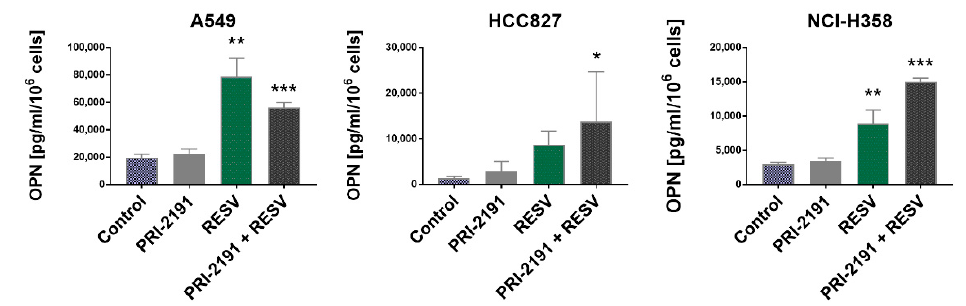
Figure 6. Effect of PRI-2191 and RESV on vascular endothelial growth factor (VEGF) secretion by lung cancer cells. RESV was used at a concentration of 20 µM and PRI-2191 at 100 nM. Cells were exposed to tested compounds for 72 h, then washed with PBS, and cultured in a serum-free medium for the next 24 h. Conditioned medium was collected, and the level of VEGF secreted by lung cancer cells was measured by ELISA. A549: * compared to control (untreated cells) and PRI-2191; NCI-H358: * compared to control ( p < 0.05, one-way ANOVA with Tukey’s post hoc with multiple comparisons).